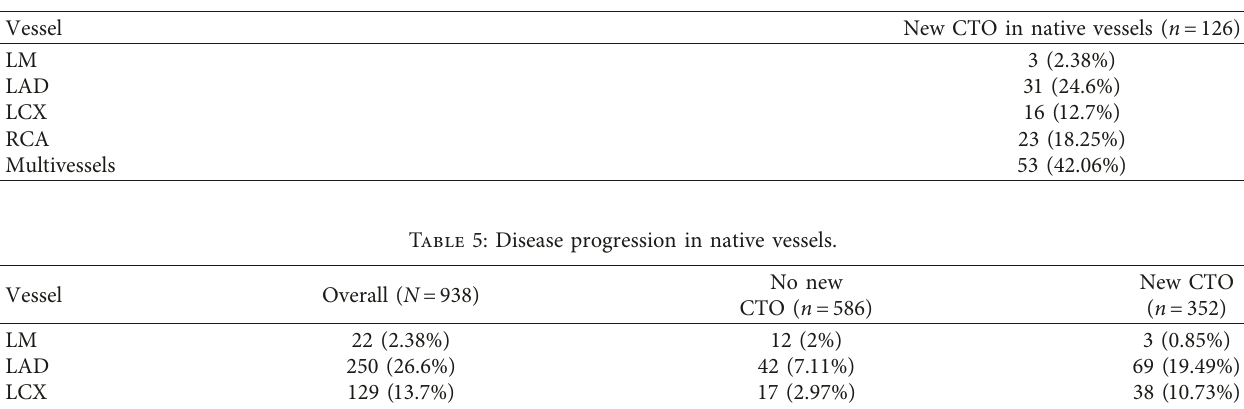
Table 4: Distribution of new CTO in native vessels.